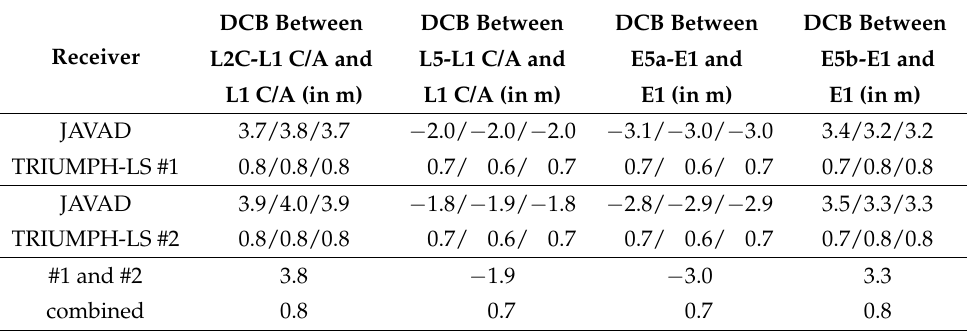
Table 5. Mean (First Line of Each Cell) and Standard Deviation (Second Line of Each Cell) of Estimated DCBs. Results from Three 24h Data Sets, Each Collected with Two Receivers on Days 151, 153 and 154 of 2018.